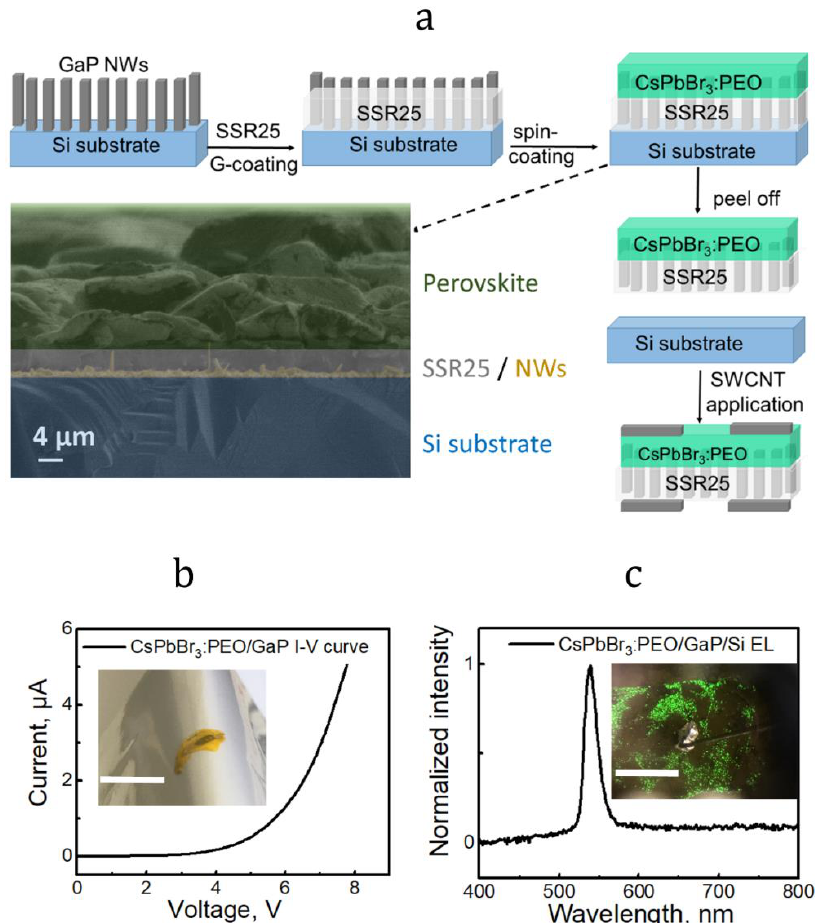
Figure 5. Scheme for creating an LED ( a ), I–V curve ( b ), and electroluminescence spectrum ( c ). Reproduced with permission [59]. Copyright 2021, American Chemical Society.